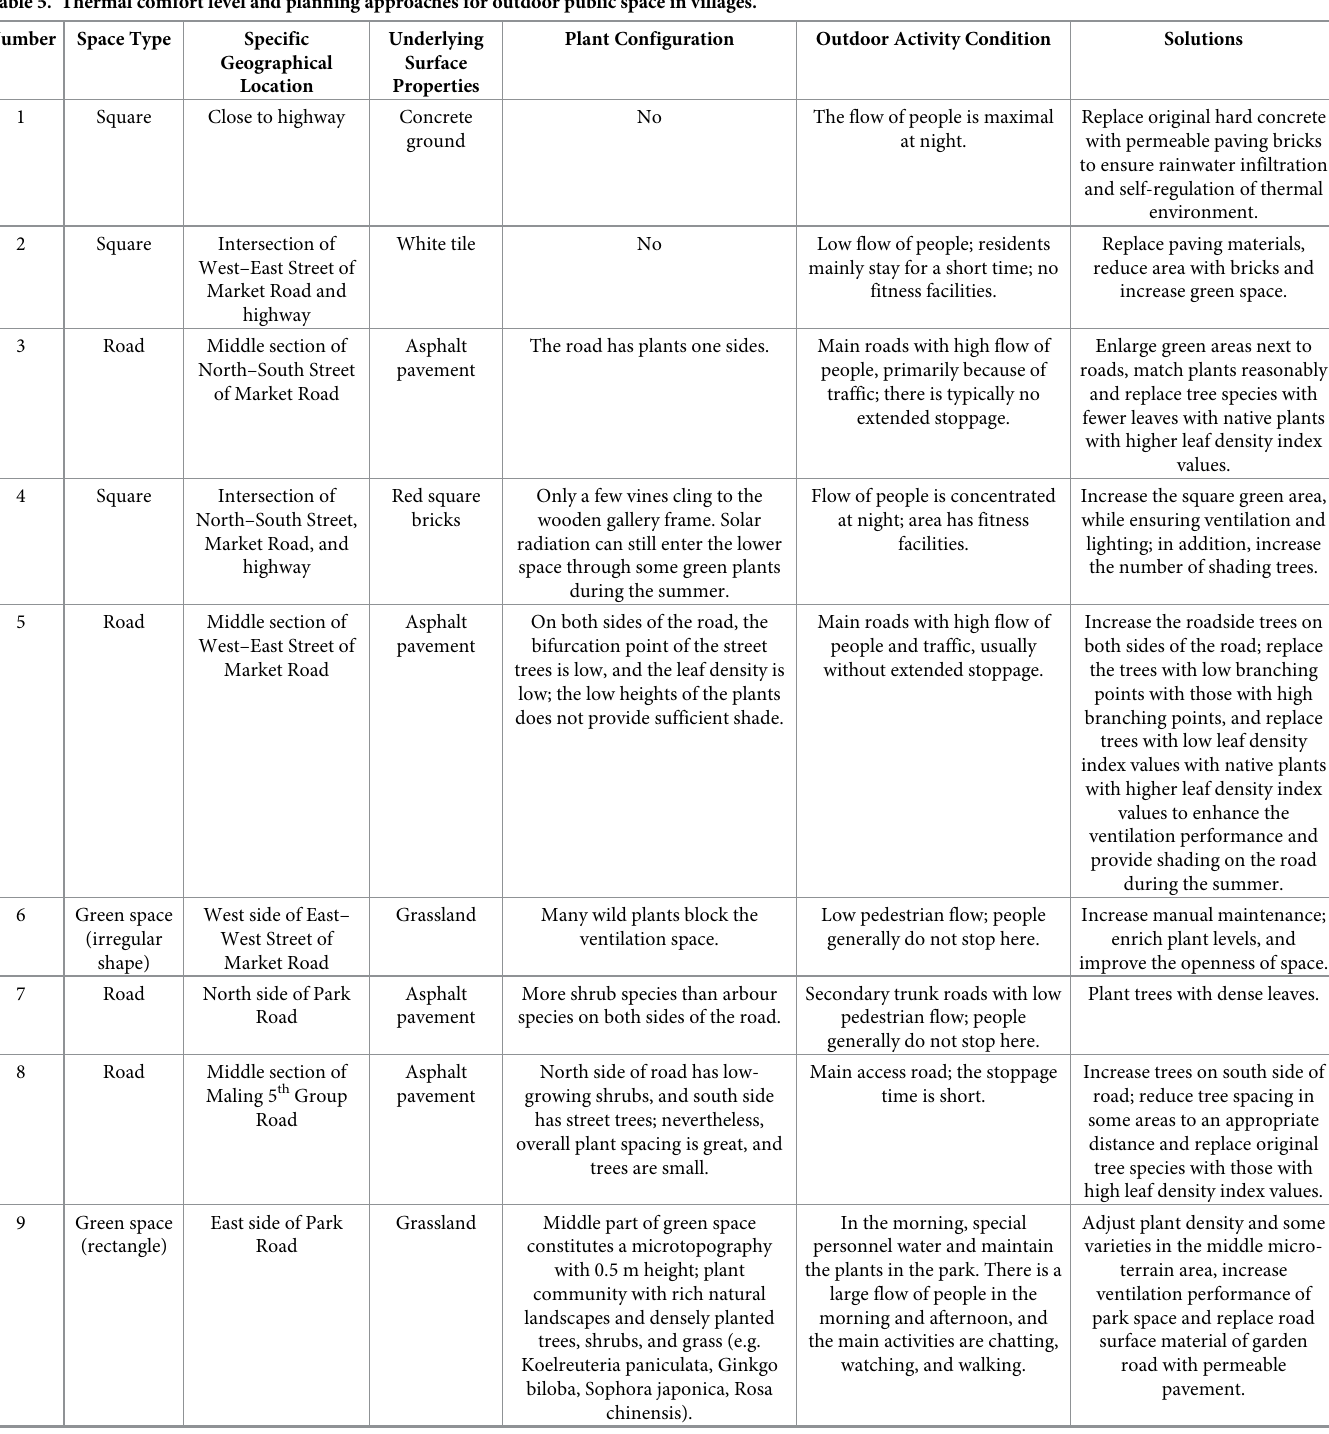
Table 5. Thermal comfort level and planning approaches for outdoor public space in